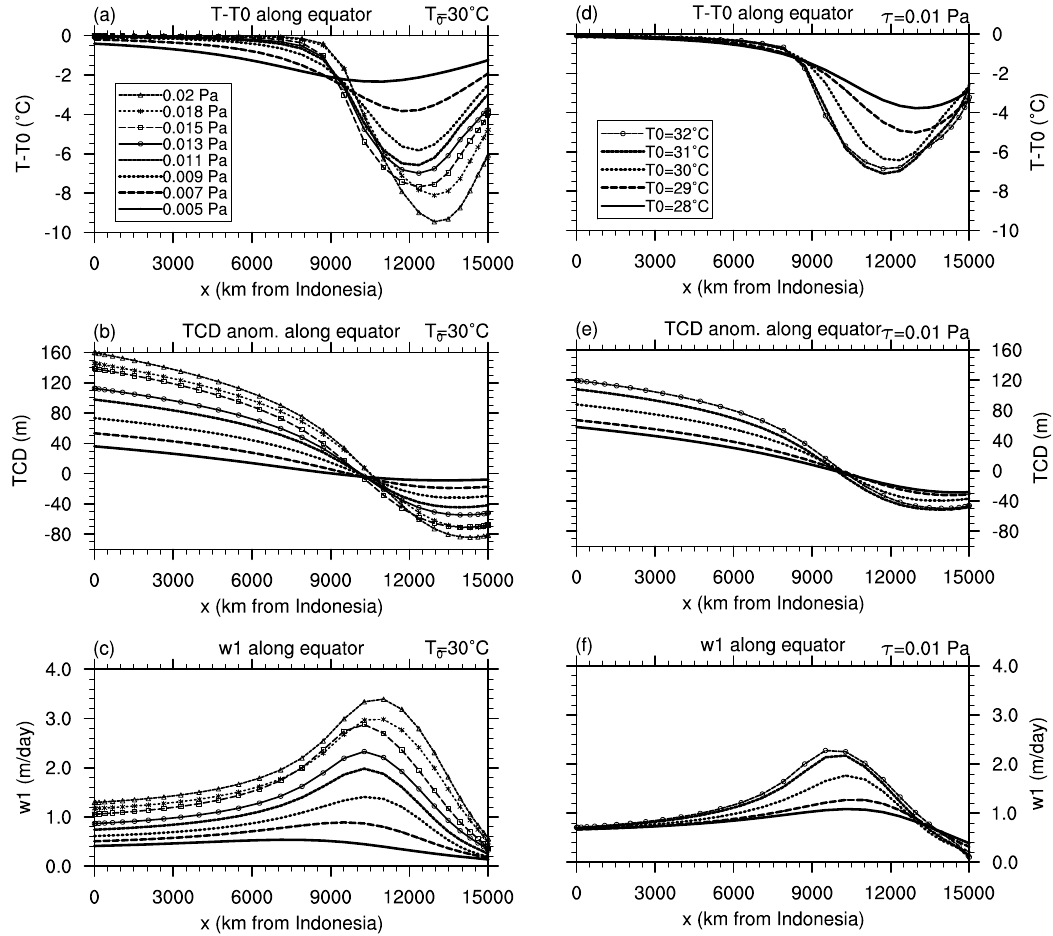
Fig. 3. Effects of changing the external wind stress τ 0 and the radiation equilibrium temperature T 0 on the climatology (i.e., the time-mean) of the tropical Pacific. (a–c) Zonal SST distribution (a) , thermocline depth anomaly (b) and upwelling velocity below the mixed layer w 1 (c) along the equator for different τ 0 between 0 . 005 − 0 . 02Pa. The equilibrium temperature T 0 is kept constant at T 0 =30 ◦ C. The legend in (a) holds for (a–c) . (d–f) Zonal SST distribution (d) , thermocline depth anomaly (e) and upwelling velocity below the mixed layer w 1 (f) along the equator for different T 0 between 28 − 32 ◦ C. The external wind stress amplitude τ 0 is kept constant at τ 0 =0.01Pa. The legend in (d) holds for (d–f)